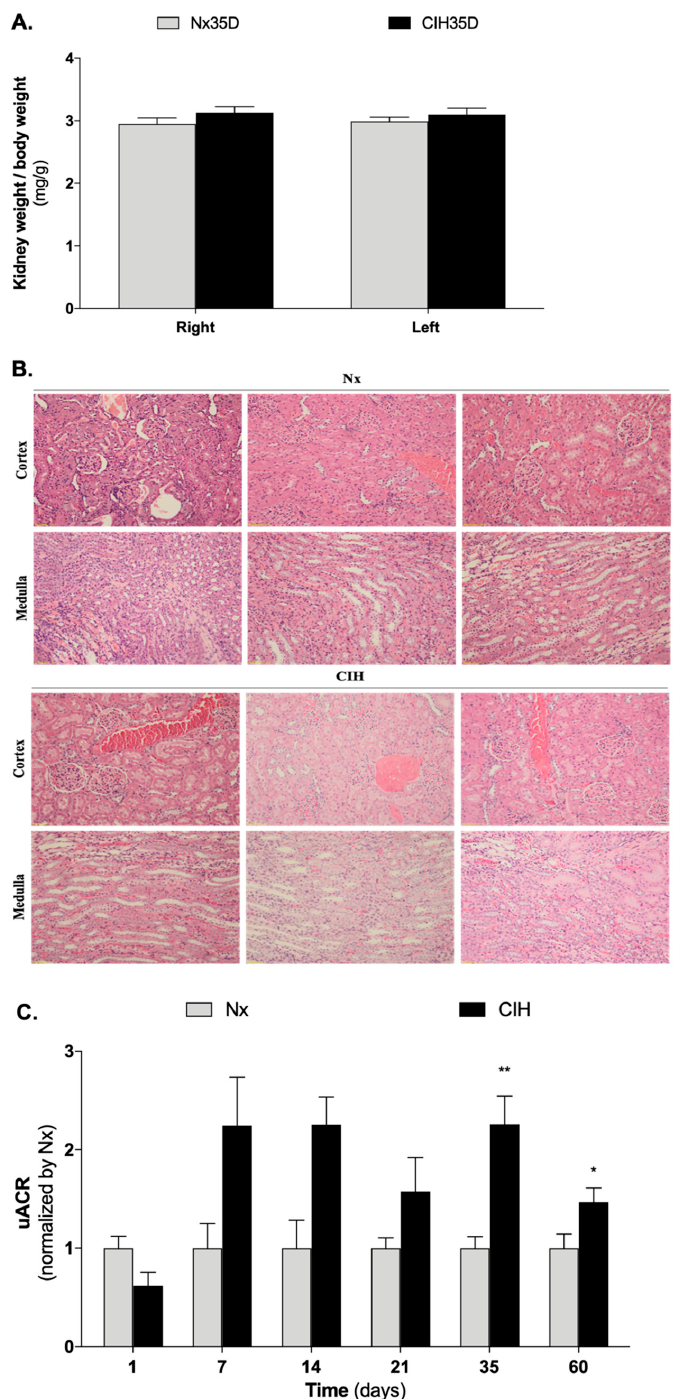
Figure 2. Impact of CIH on ( A ) kidney weight, ( B ) kidney histology, and ( C ) uACR. ( A ) No differences were found in the ratio of kidney weight to body weight ( n = 6 for Nx35D; n = 8 for CIH35D). ( B ) No relevant histological changes were observed for the left kidney of all groups ( n = 3 animals per group). Staining was performed in 10% formaldehyde-fixed paraffin-embedded left kidney sections using H&E; Magnification: 10 × ; ( C ) CIH increases uACR. Number of animals per group: Day of study ( n for Nx; n for CIH): D1 (8; 4), D7 (4; 4) D14 (4; 2) D21 (6; 8); D35 (6; 8); D60 (9; 7). Multiple t -test; comparison Nx vs. CIH: * p < 0.05; ** p < 0.01. CIH: chronic intermittent hypoxia; Nx: normoxic; uACR: urinary albumin-to-creatinine